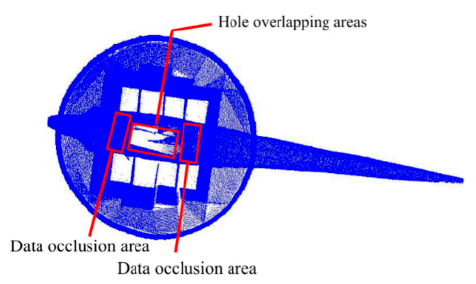
Figure 18. Schematic of data occlusion and hole overlapping areas.